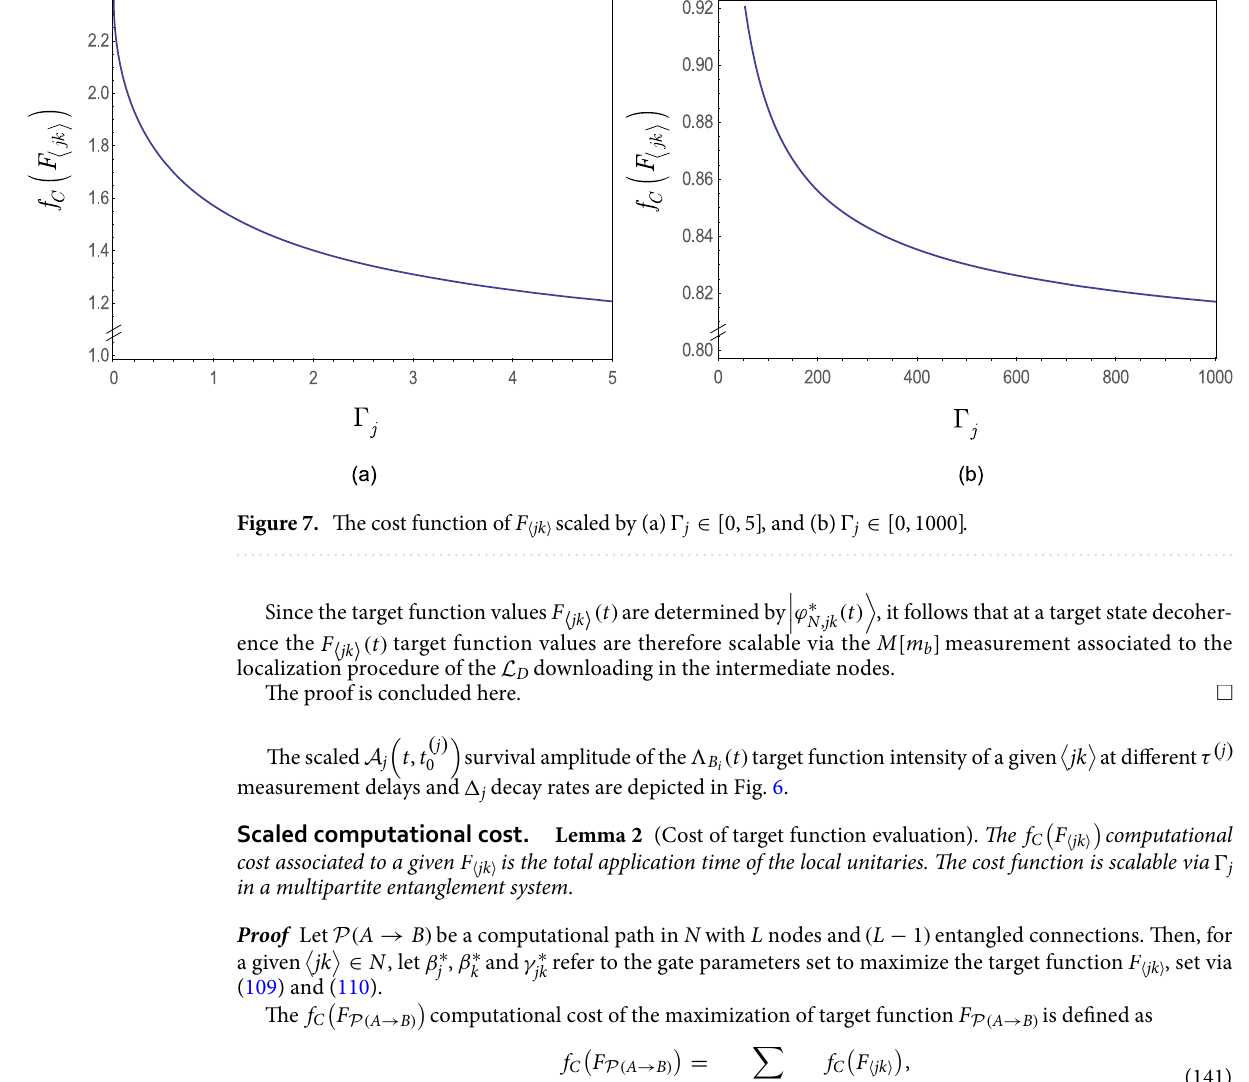
Figure 7. The cost function of F